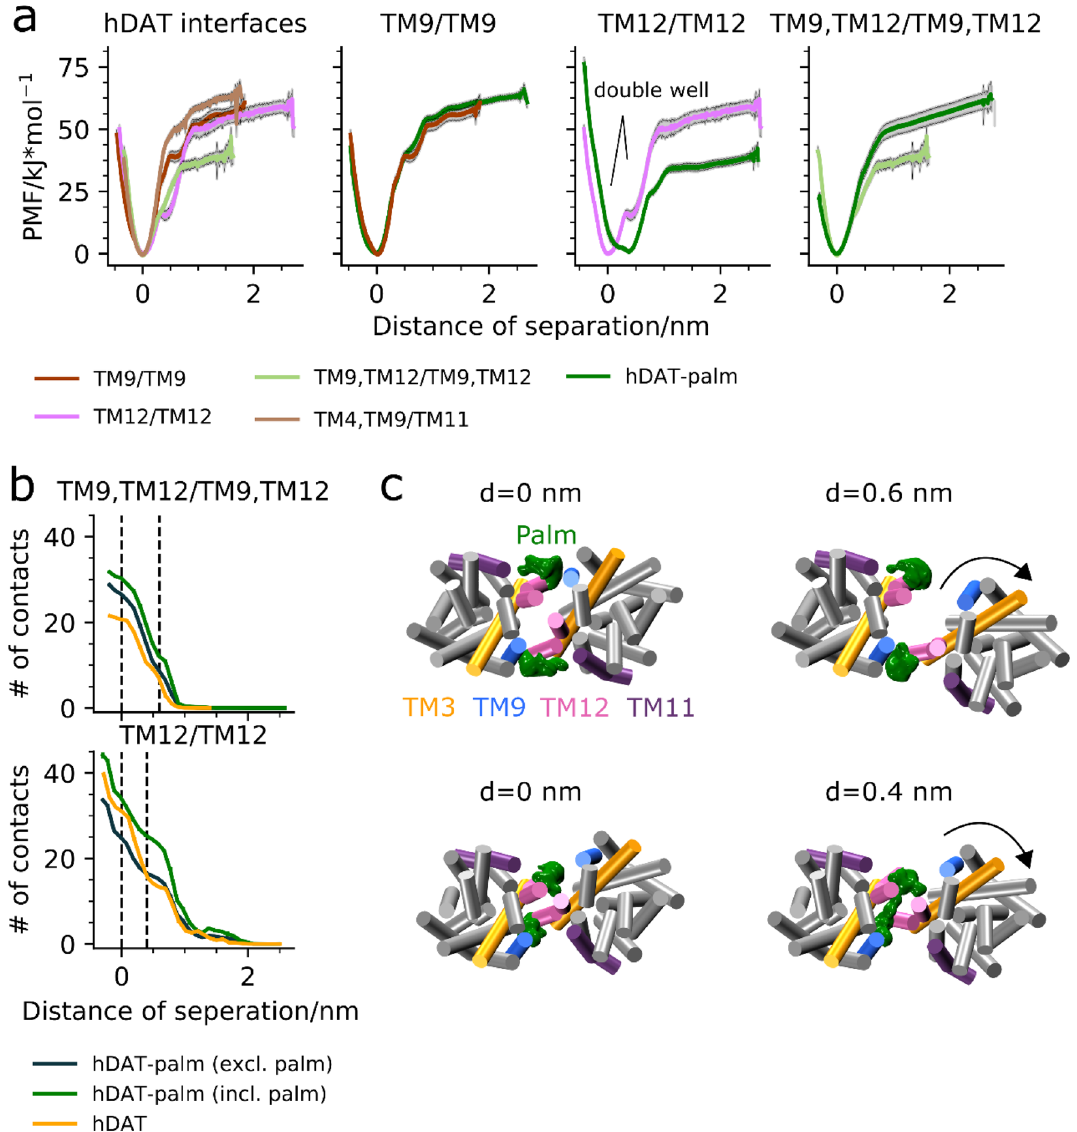
Figure 3. Potential of mean force energy profiles and contact analysis of hDAT and hDAT-palm interfaces. Illustrated in the first panel in ( a ) are all the PMFs of the different hDAT interfaces: TM9/TM9 (brown), TM9,TM12/TM9,TM12 (light green), TM12,TM12 (pink), and TM4, TM9/TM11 (light brown). Shown in the subsequent plots are PMF comparisons of the interfaces TM9/TM9, TM9,TM12/TM9,TM12, and TM12/TM12 between hDAT and hDAT-palm (green). Shown in ( b ) are the average number of residue contacts calculated within 1 Å distance bins along hDAT dimer separation relative to the distance at energy minimum as detected from the PMF energy profiles. The number of residue contacts for the two systems, hDAT and hDAT-palm, at the two interfaces, TM12/TM12 and TM9, TM12/TM9, TM12, were monitored. For both interfaces the Cys581 residue where palm is attached is either included (incl.) or excluded (excl.) from the contacts analysis. A contact was counted when the distance between two residue pairs was below 7 Å. Each contact was unbiased. Error bars have been included by performing bootstrapping on the data using 10 iterations, although they are barely visible. Shown in ( c ) are representative dimer conformations of hDAT-palm at different separation distances for the TM9, TM12/TM9, TM12 interface (top) and the TM12/TM12 interface (bottom). Highlighted are helices TM3, TM9, TM11 and TM12. The green mesh corresponds to the palm occupancies calculated using the Volmap plugin in VMD for the dimer conformations found around the given separation distance. For the Volmap calculations the size of the system beads were set to 2.6 Å and the “occupancy” setting was selected. The arrows indicate the movement of the proteins with respect to each